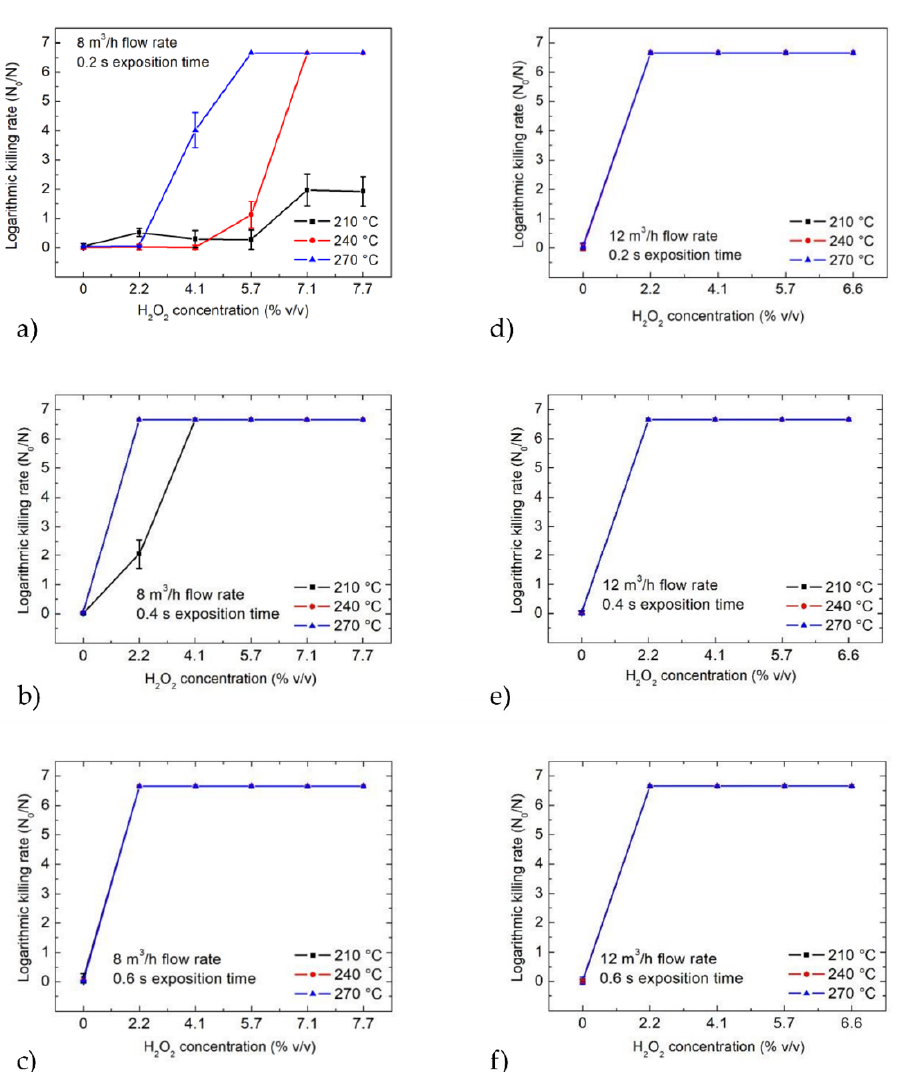
Figure 7. Spore viability validated by count reduction testing. The spores were sterilized in different scenarios. The H 2 O 2 sterilization of B. atrophaeus DSM 675 with a gas flow rate of 8 m 3 /h ( a – c ) and with a gas flow rate of 12 m 3 /h ( d – f ), with varying exposure times of 0.2, 0.4 and 0.6 s at gas temper- atures of 210, 240 and 270 °C with H 2 O 2 concentrations of between 0 and 7.7 or 6.6% v/v